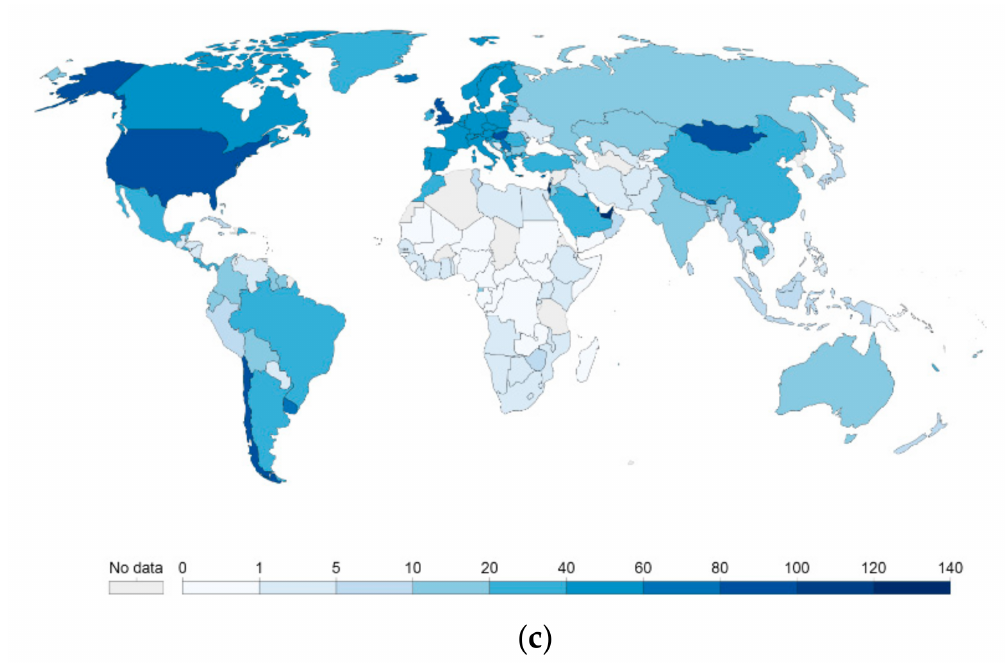
Figure 8. Cumulative COVID-19 vaccine doses administered per 100 people in a country’s total population in different Asian countries. Data counted single-dose vaccine doses issued per 100 people in the total population up to 24 May 2021. ( a ) Cumulative COVID-19 vaccine data (doses administered per 100 people) in different Asian countries are represented through the linear graph. ( b ) Cumulative COVID-19 vaccine data (doses administered per 100 people) in various Asian countries described through the log graph. ( c ) Cumulative COVID-19 vaccine data (doses administered per 100 people) in different Asian countries represented through the Asian map (data source: Our World in Data).